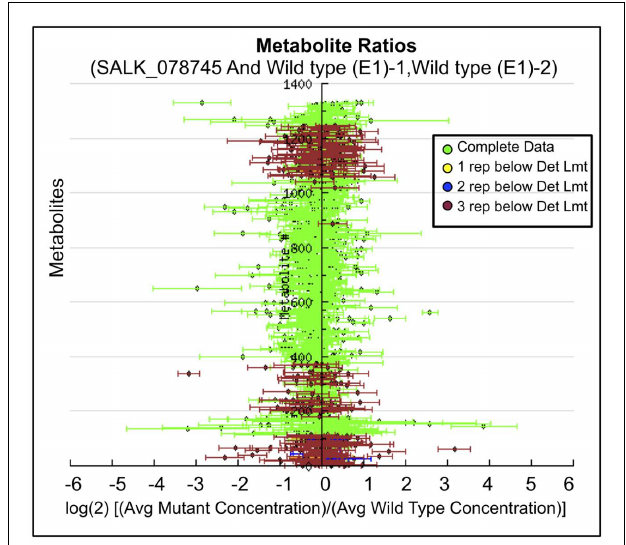
FIGURE 3 | Log-ratio plot of the metabolome of the oxp1 (SALK_078745) mutant. The y -axis plots individual metabolites.The x -axis plots log-transformed relative ratio of abundance of each metabolite in the mutant sample normalized to the levels of that metabolite in the wild-type control sample.The calculation of SE is described in the Section “Materials and